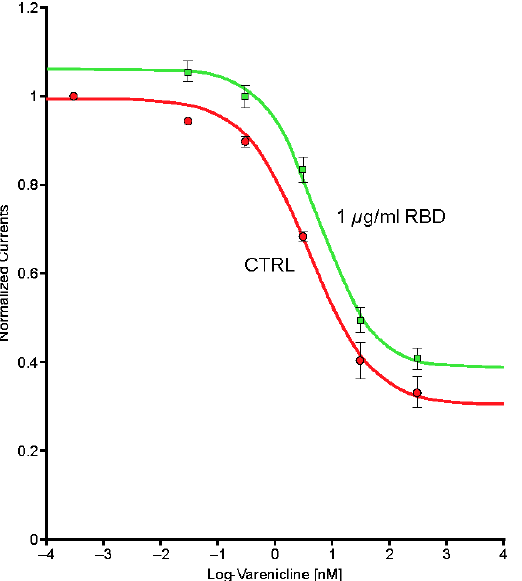
Figure 8. Peak inward currents evoked by 50- µ M acetylcholine were recorded in a series of cells for control ( n = 7; red) and during exposure to 1- µ g/mL spike protein containing the receptor-binding domain (Spike-RBD) ( n = 8; green) and normalized to unity vs. the response recorded in control. Continuous lines are the best fits obtained with the Hill equation. CTRL, control; log, logarithm.